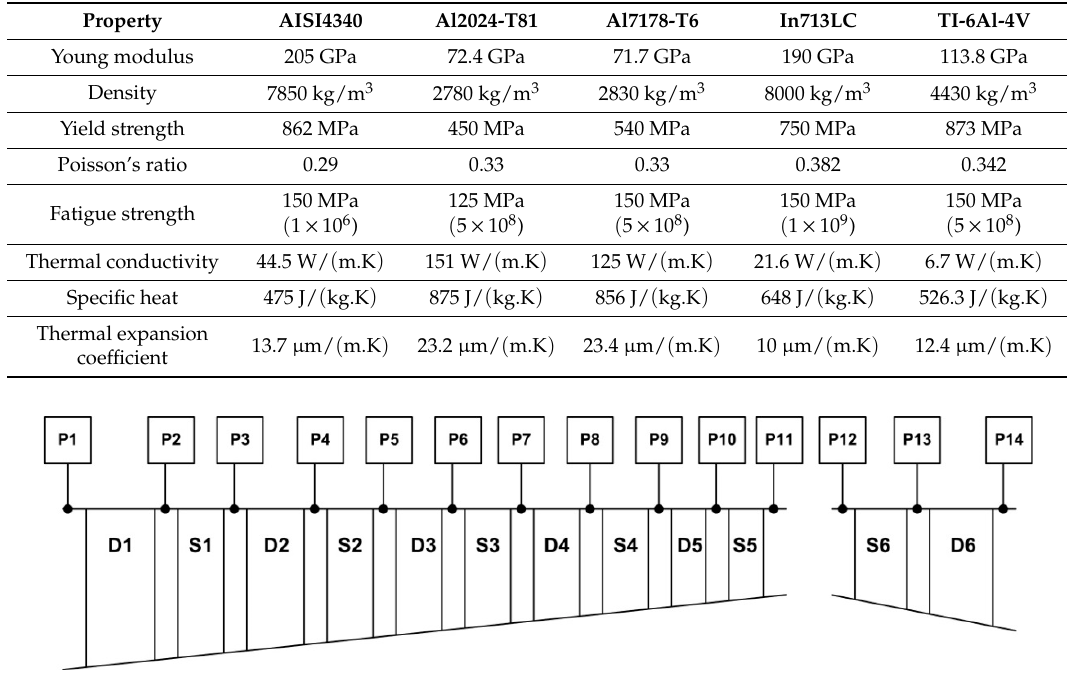
Figure 5. Working fluid pressures in measurement points at the compressor and turbine stages. Table 3. Numerical values of working fluid pressures at the compressor and turbine stages.